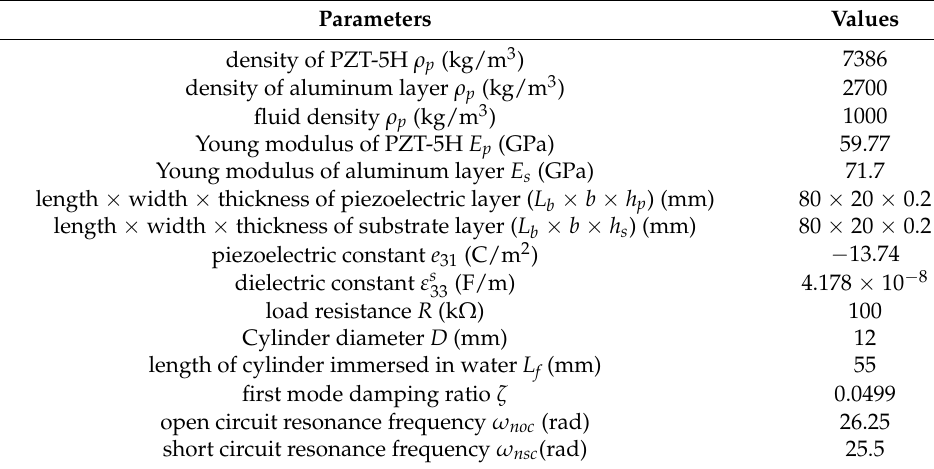
Table 1. Dimension and material properties of the